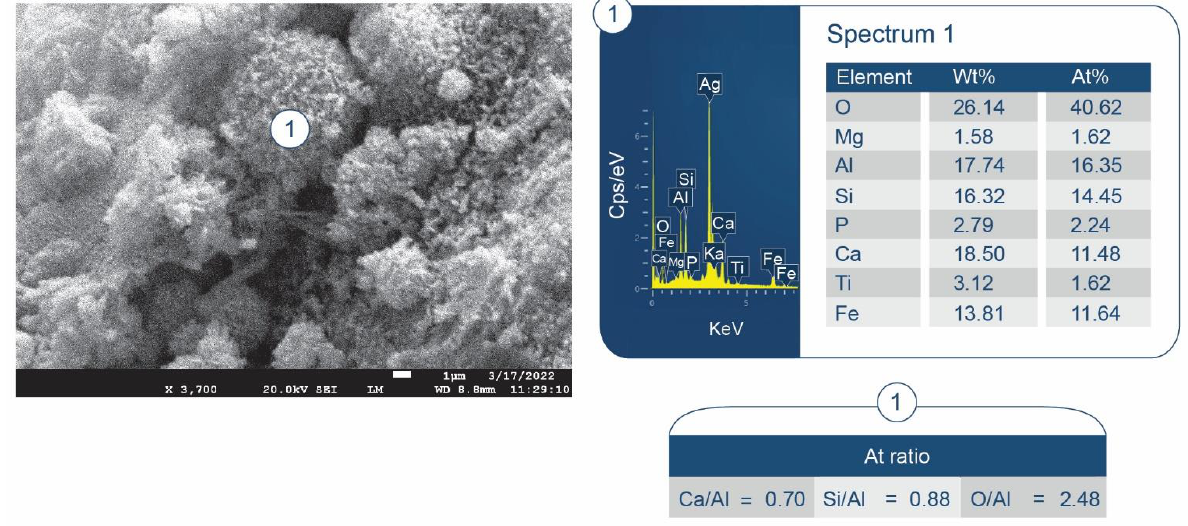
Figure 39. Photomicrograph of 250 °C-autoclaved 87/13 ratio composite at the location of FCS. As in the case of albite, the orthosilicic acid (H 4 SiO 4 ) derived from alkali (OH) − disso- lution of silica gels can serve as a source of Si for dmisteinbergite formation [83]: Ca 2+ + 2Al(OH) 4 − + 2H 4 SiO 4 ( aq ) ↔ CaAl 2 Si 2 O 8 + 8H 2 O.